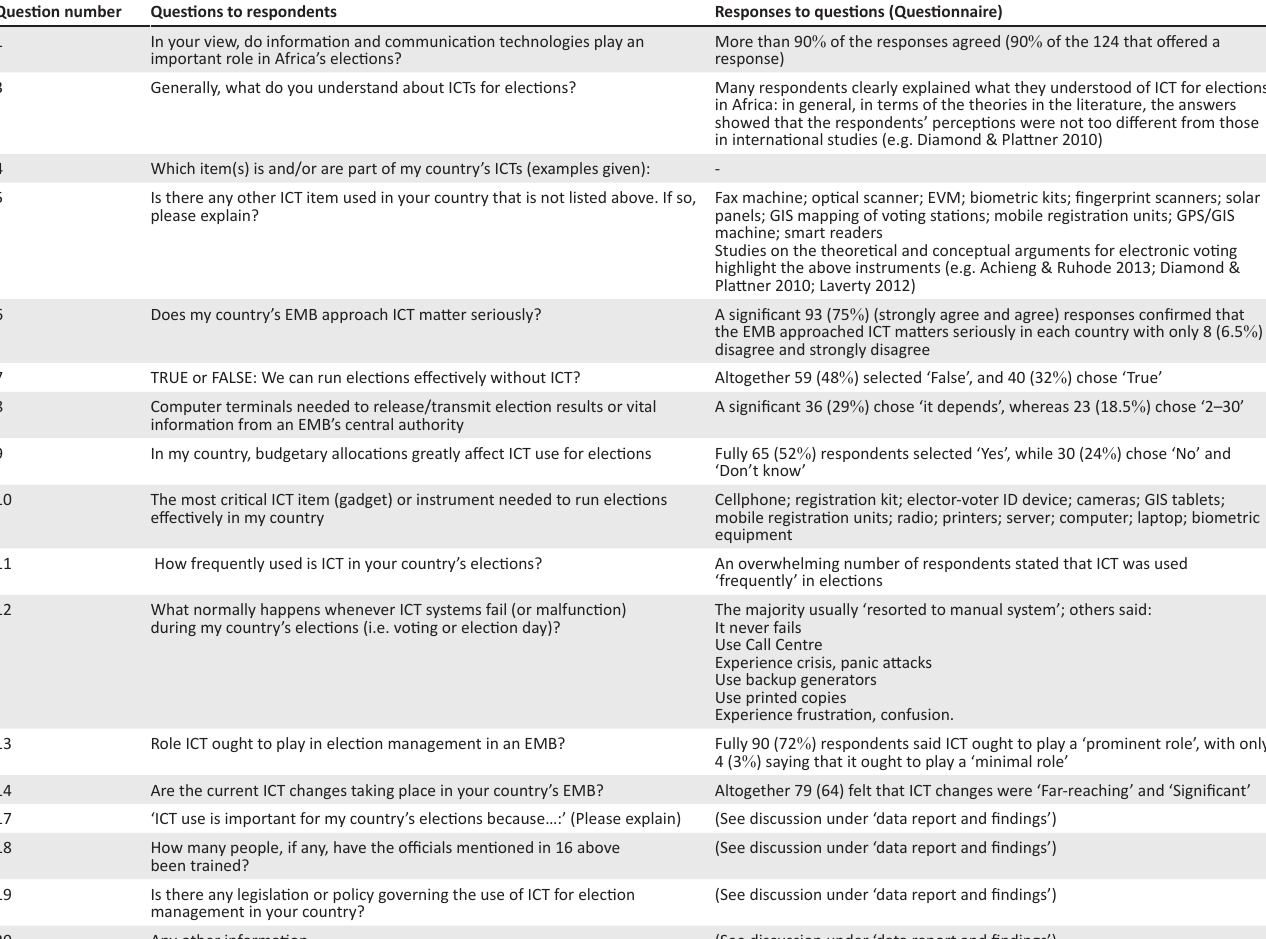
TABLE 1: List of questions asked and summary of responses. Question number Questions to respondents Responses to questions